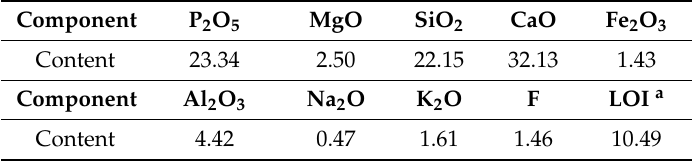
Table 1. The chemical compositions of the phosphate ore by X-ray fluorescence analysis (wt %).